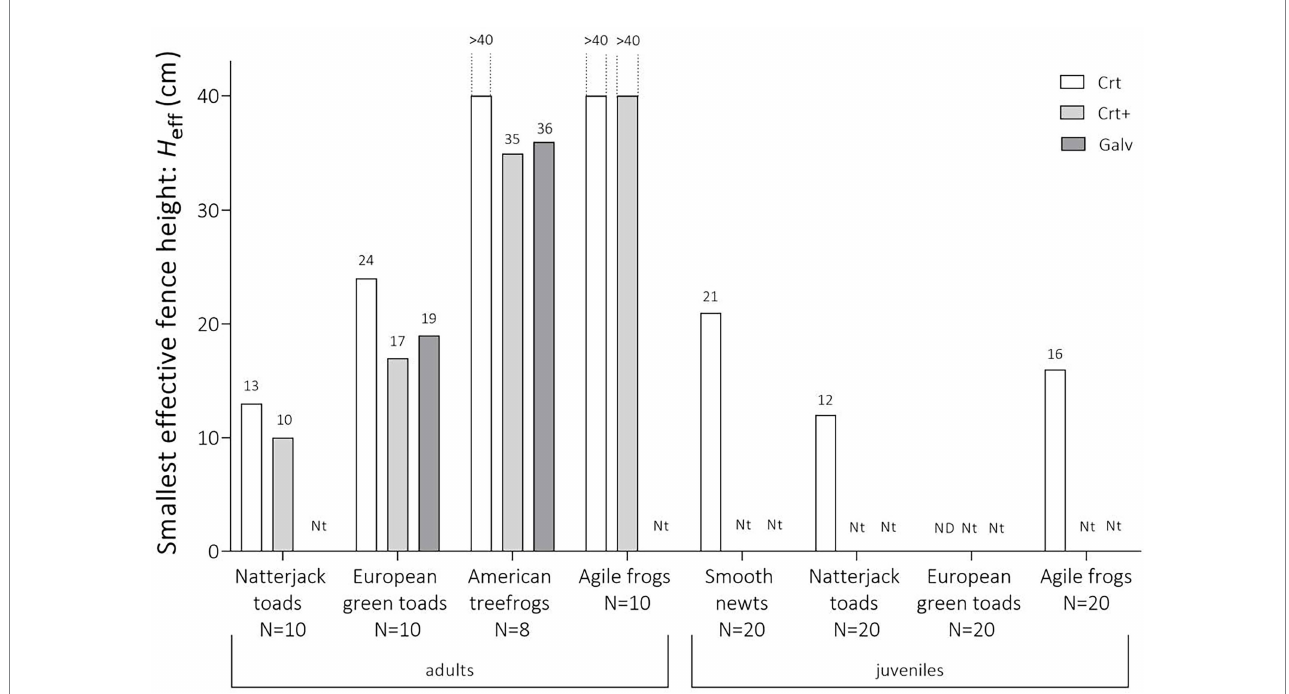
FIGURE 4 Smallest effective fence height (H eff ) for the amphibian species/developmental stages tested that prevented them to cross over various fence types, as indicated by different bar colors [white: simple concrete fence (Crt); light gray: concrete fence with a 10 cm horizontal overhang (Crt+); dark gray: galvanized fence (Galv)] with a bent overhang. Note that not all fence types could be tested with all species/developmental stages, as indicated by ‘Nt’ (not tested). Juvenile green toads never attempted to cross the fences tested, so that we could not determine H eff in that case, as indicated by ND (not determined).